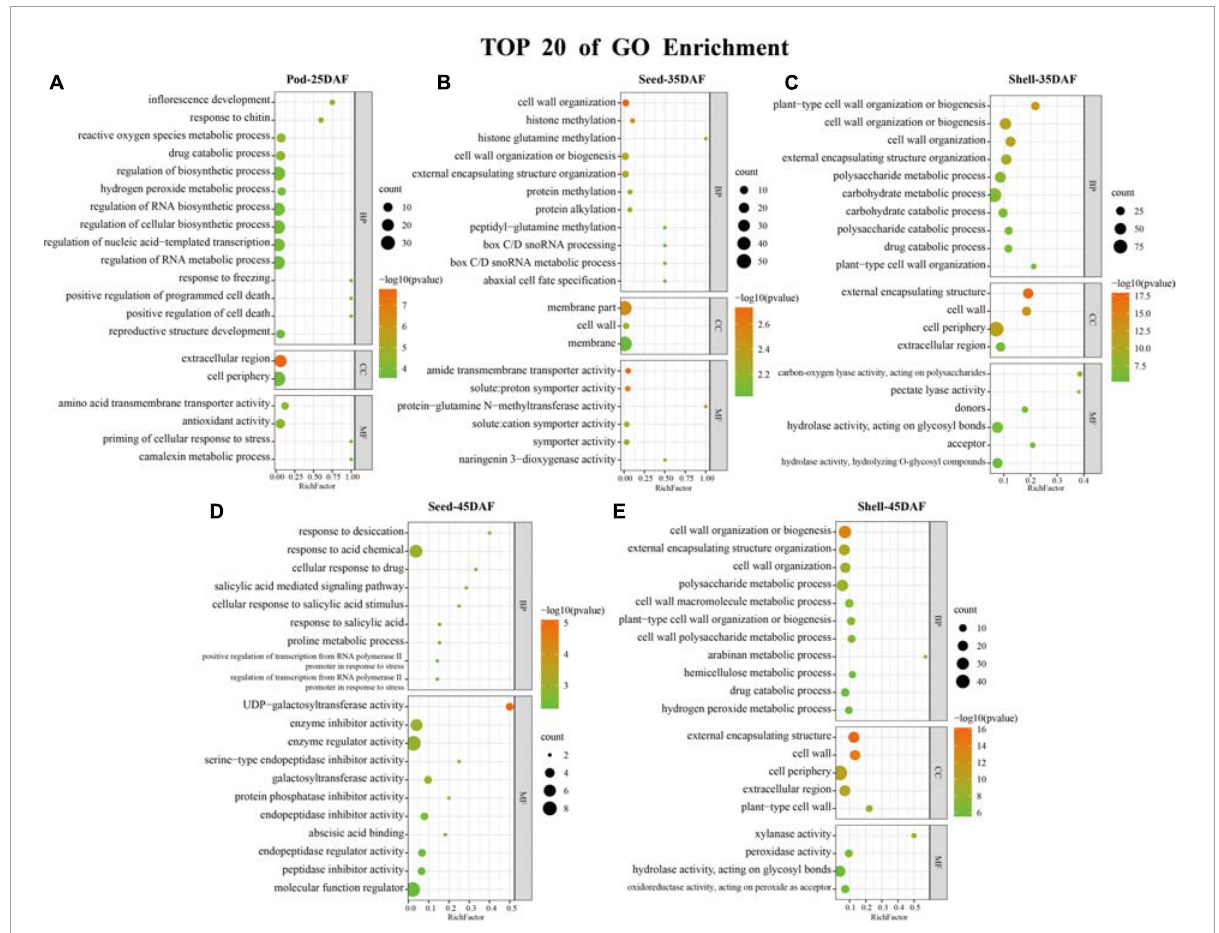
FIGURE4 Gene Ontology (GO) Enrichment analysis. (A–E) Top 20 terms of GO enrichment results in five phases: Pod-25, Seed-35, Shell-35, Seed-45, and Shell-45 DAF. The color scale indicates significance (corrected p -value). The size of the circle represents the number of genes enriched by that